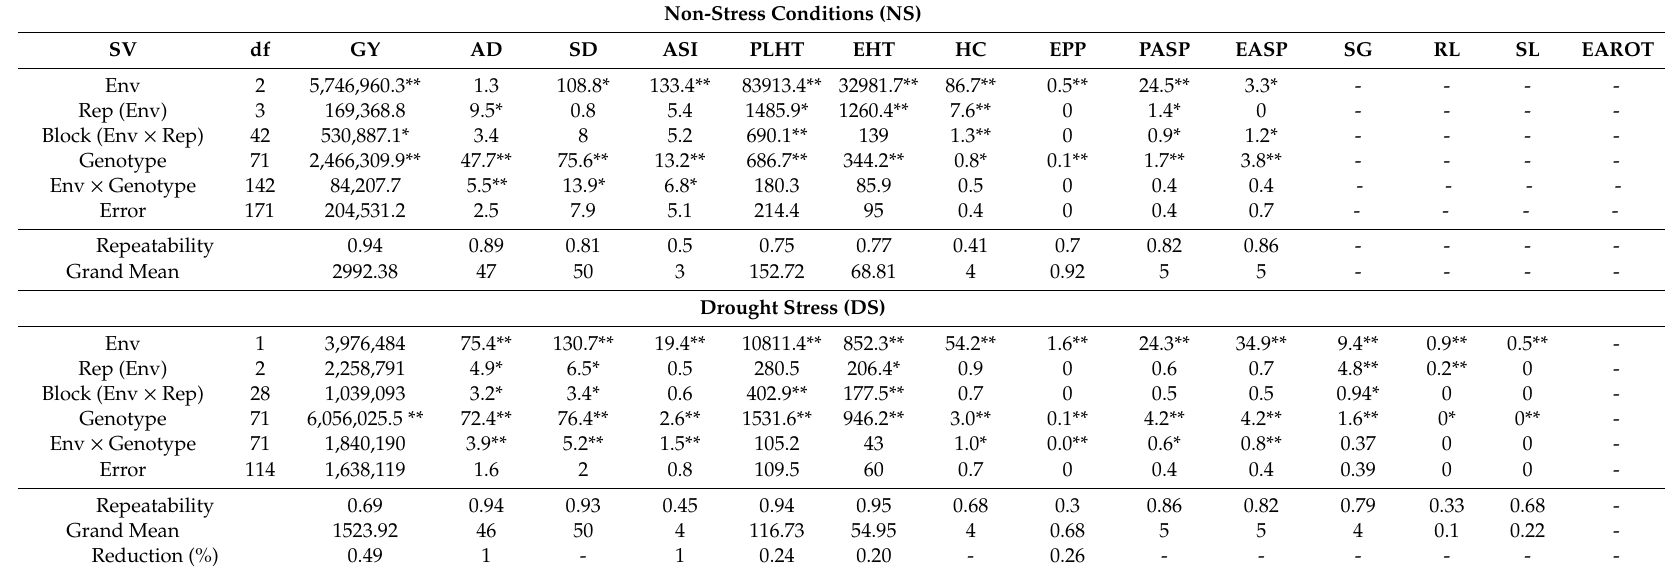
Table 1. Mean squares, and repeatability of grain yield and other traits of 72 extra-early maturing maize accessions evaluated under non-stress and drought stress conditions between 2017 and 2019 at Kadawa,